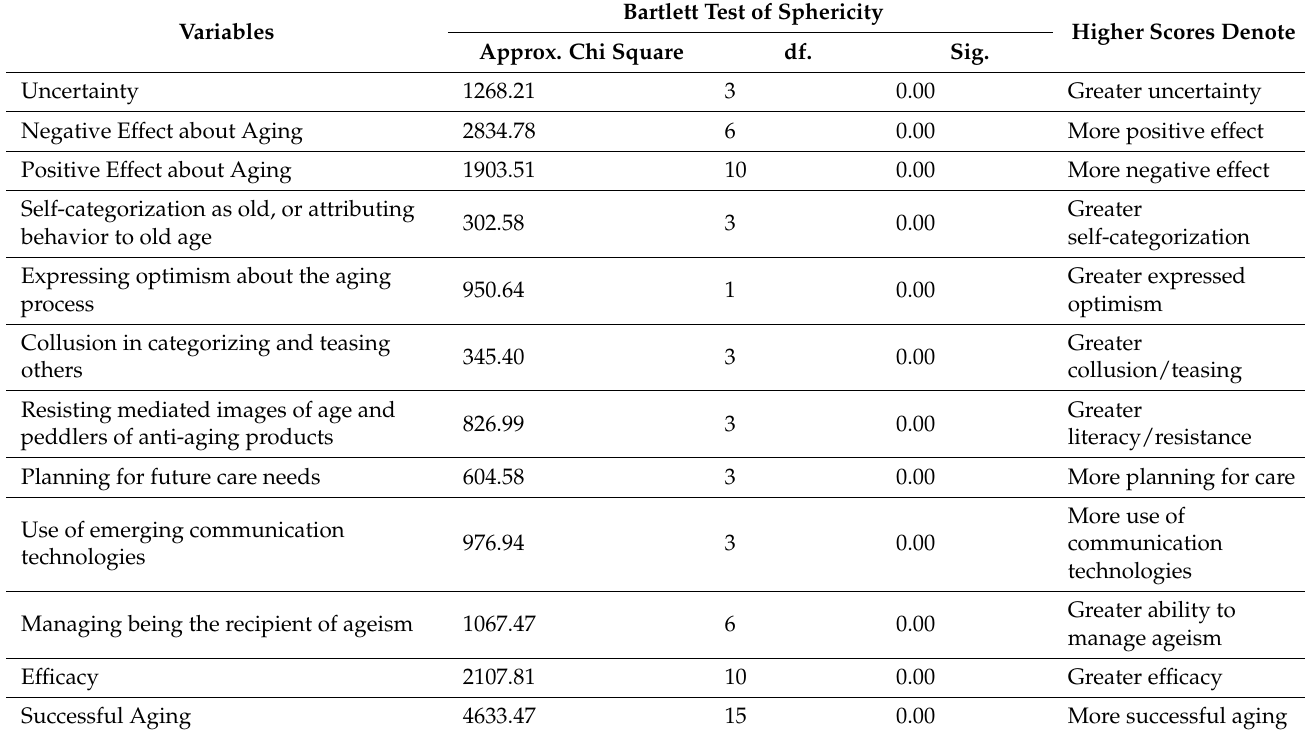
Table A2. Result of Bartlett Test of Sphericity and Meaning of Higher